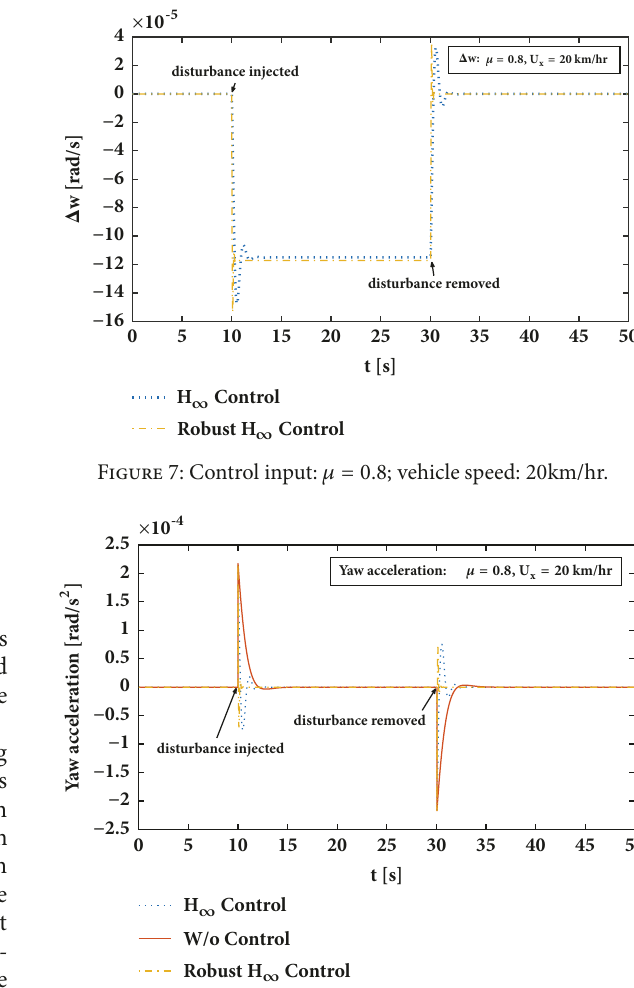
Figure 8: Yaw acceleration: 𝜇 = 0.8 ;